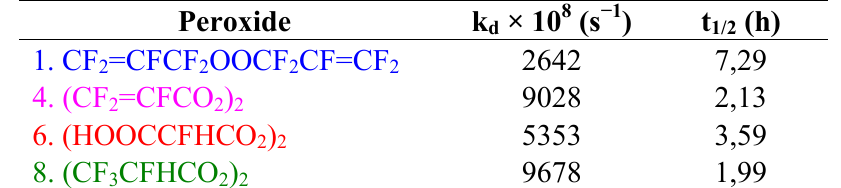
O to FAFS—k 2 2